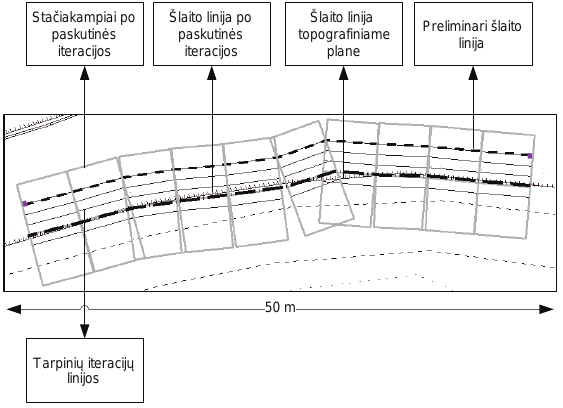
Fig. 5. Surface break line created by choosing parameters